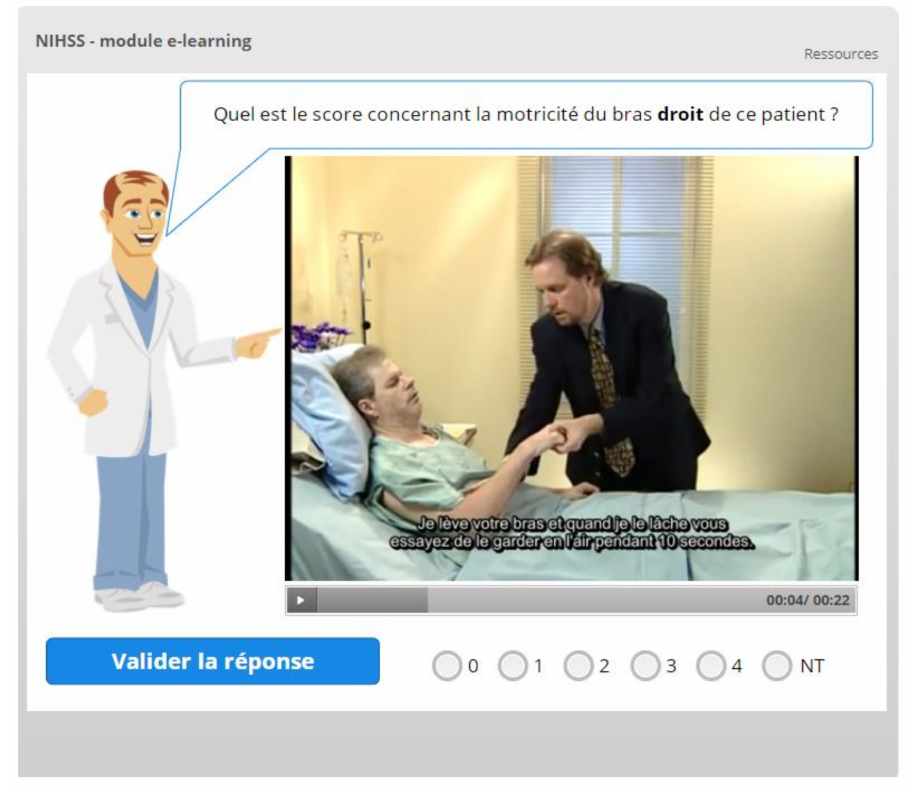
Figure 3. Embedded video and quiz interaction.